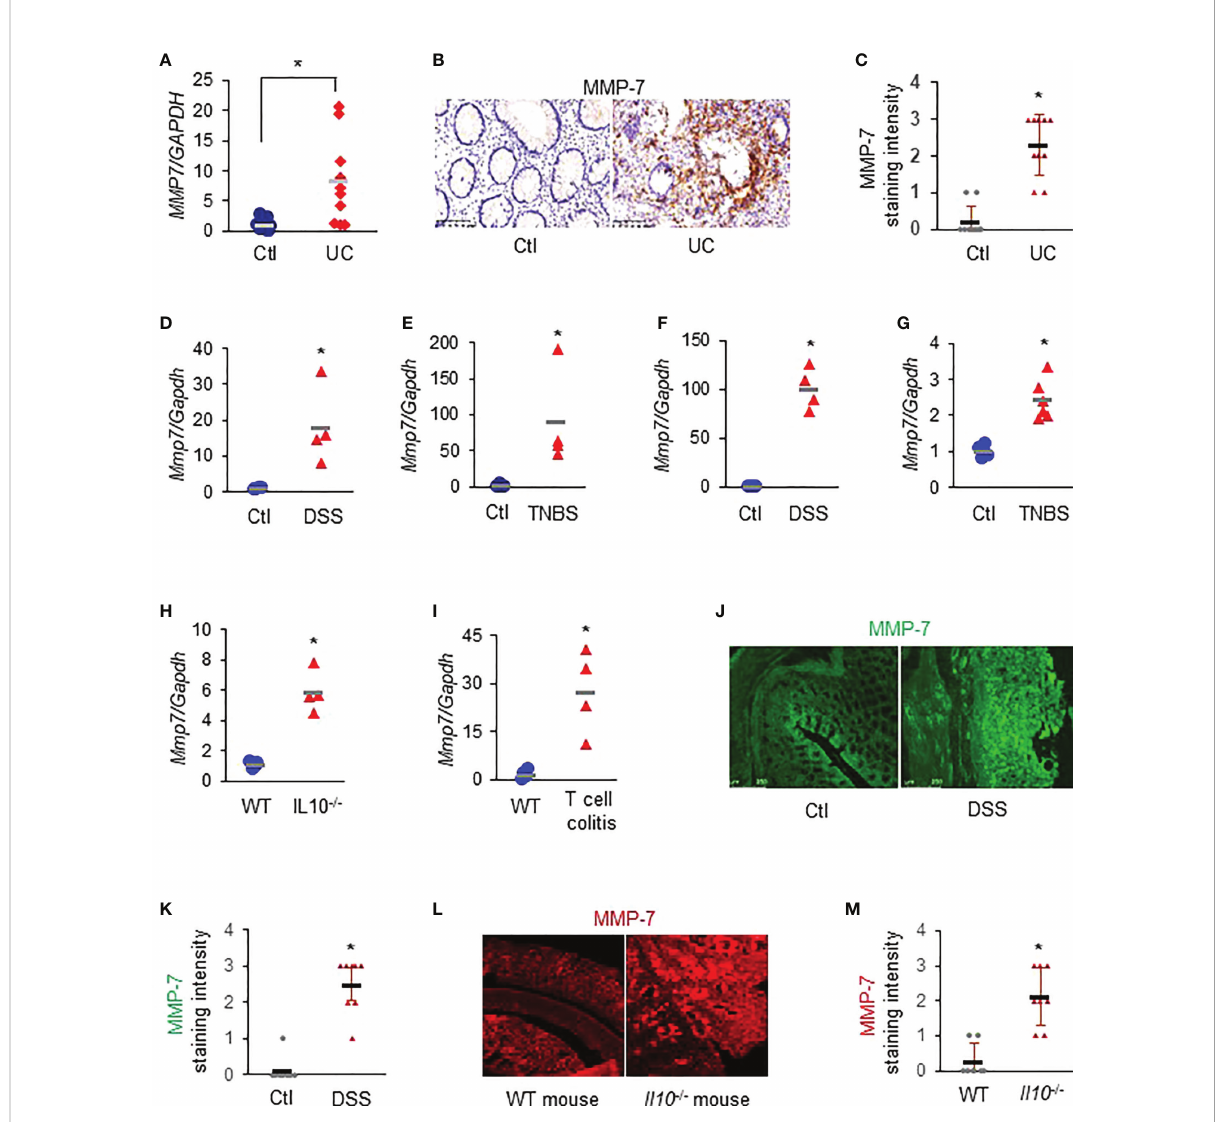
FIGURE 1 MMP-7 is highly expressed in patients with ulcerative colitis (UC) and in rodents with experimental colitis. (A) RT-qPCR analysis of MMP7 mRNA levels in mucosa biopsies from control subjects and patients with UC ( n =10). (B) Representative images of immunostaining for MMP-7 in human colon biopsy samples. (C) Quanti fi cation of MMP-7 staining intensity, ranging from absent (0) to highest (3). RT-qPCR also showed up- regulation of Mmp7 mRNA expression in the colons of DSS rats (D) , TNBS rats (E) , DSS mice (F) , TNBS mice (G) , IL10 -/- mice (H) , and T-cell transfer colitis mice (I) . n=4 or 5. * p <0.01. (J) Immuno fl uorescence staining of MMP-7 in the colons of control (Ctl) and DSS rats. (K) MMP-7 protein staining intensity in control and DSS rats. (L) Representative images of MMP-7 staining of the colons from WT and Il10 -/- mice. (M) Quanti fi cation of MMP-7 staining intensity in the colons of WT and Il10 -/-